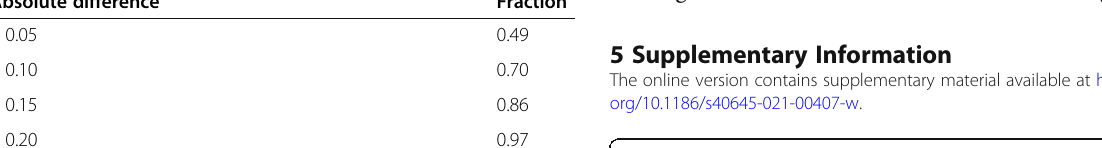
Table 4 Absolute difference between actual and simulated COVs Absolute difference Fraction